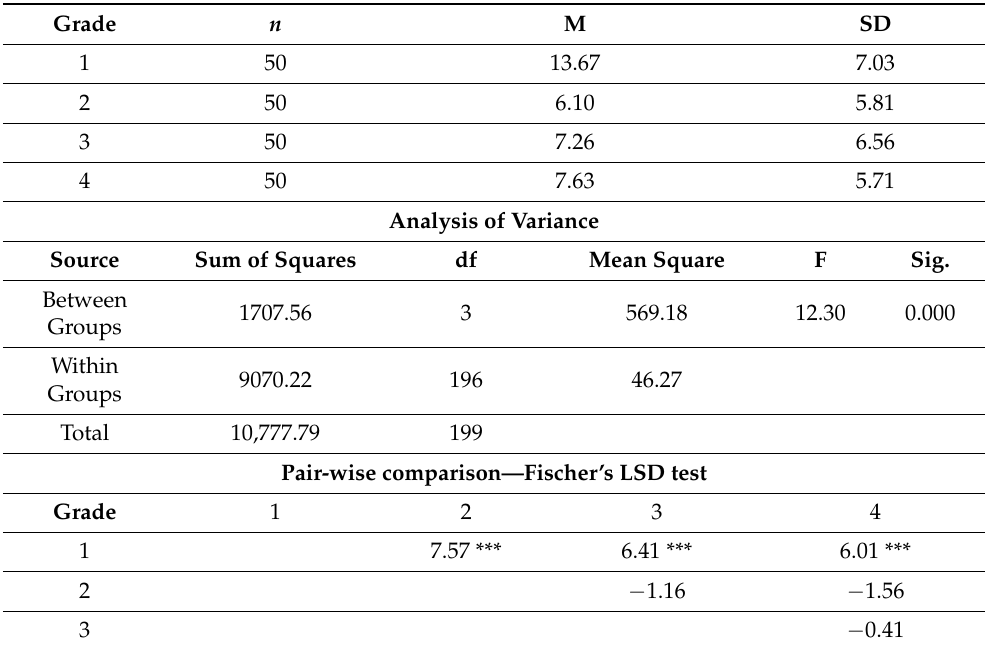
Table 3. Analysis of variance of the average HPSQ-Thai version total score for each